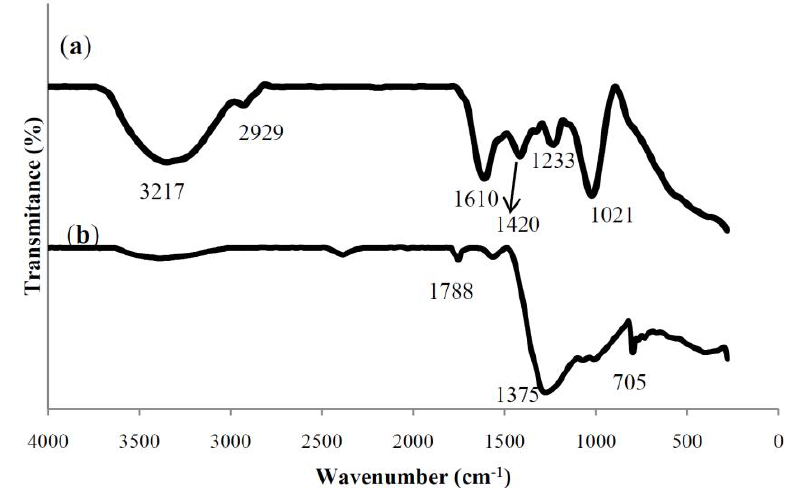
Figure 3. FT-IR spectrum for ( a ) the S. muticum a queous extract; and ( b ) S. muticum formed